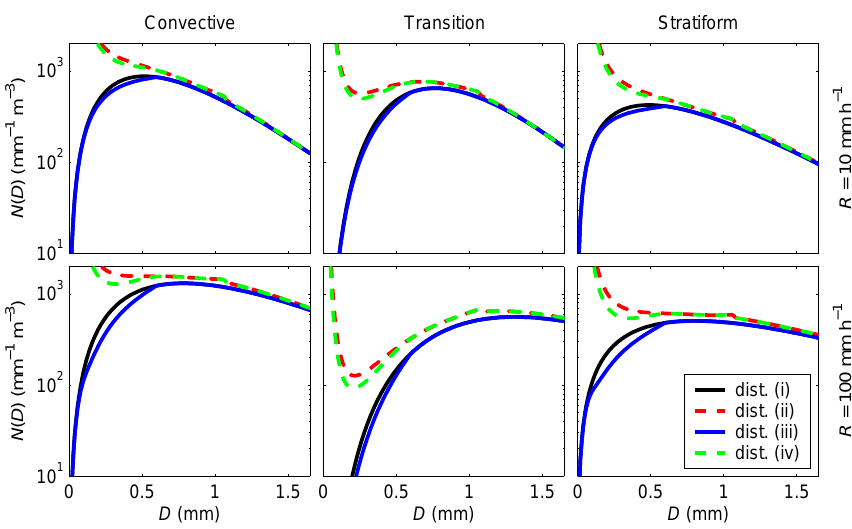
Fig. 5. As Fig. 4, but for simulated 2DVD measurements.